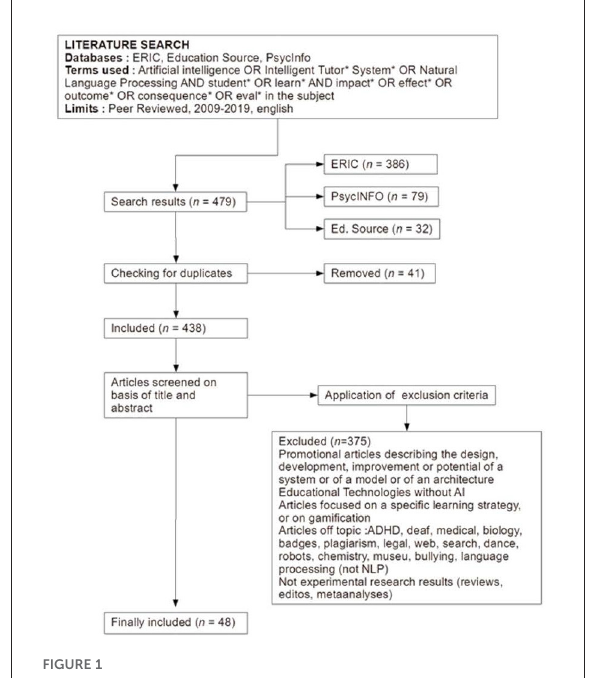
FIGURE1 Flowchart of data